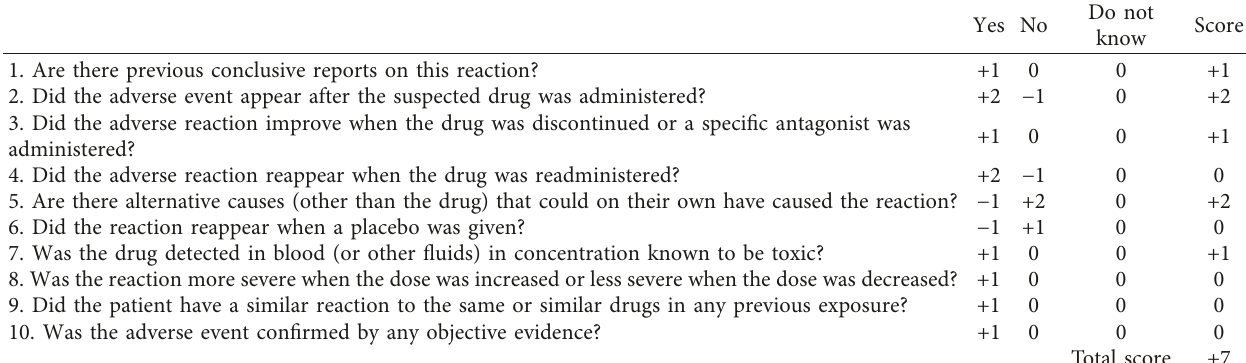
Table 2: Evaluation of the causal relationship between perampanel and impaired consciousness using the Naranjo